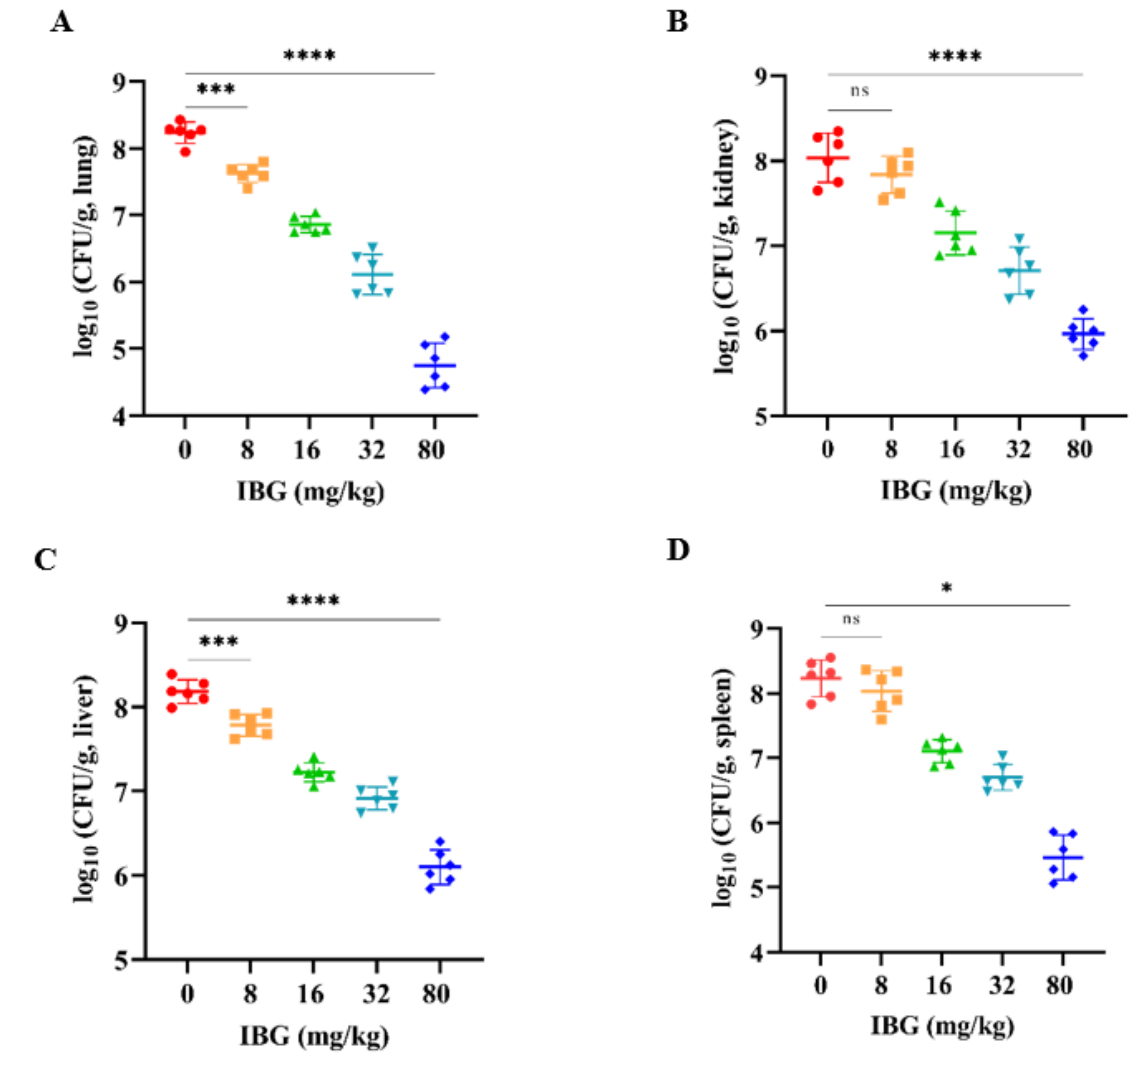
Figure 4. Bacterial load of ( A ) lung, ( B ) kidney, ( C ) liver, and ( D ) spleen tissues of SS3-infected mice after treatment with different doses of IBG. IBG significantly reduced the bacterial load of lung, kidney, liver, and spleen tissues. An unpaired two-tailed t -test was used for statistical analysis. *, p < 0.01, ***, p < 0.001, ****, p < 0.0001.